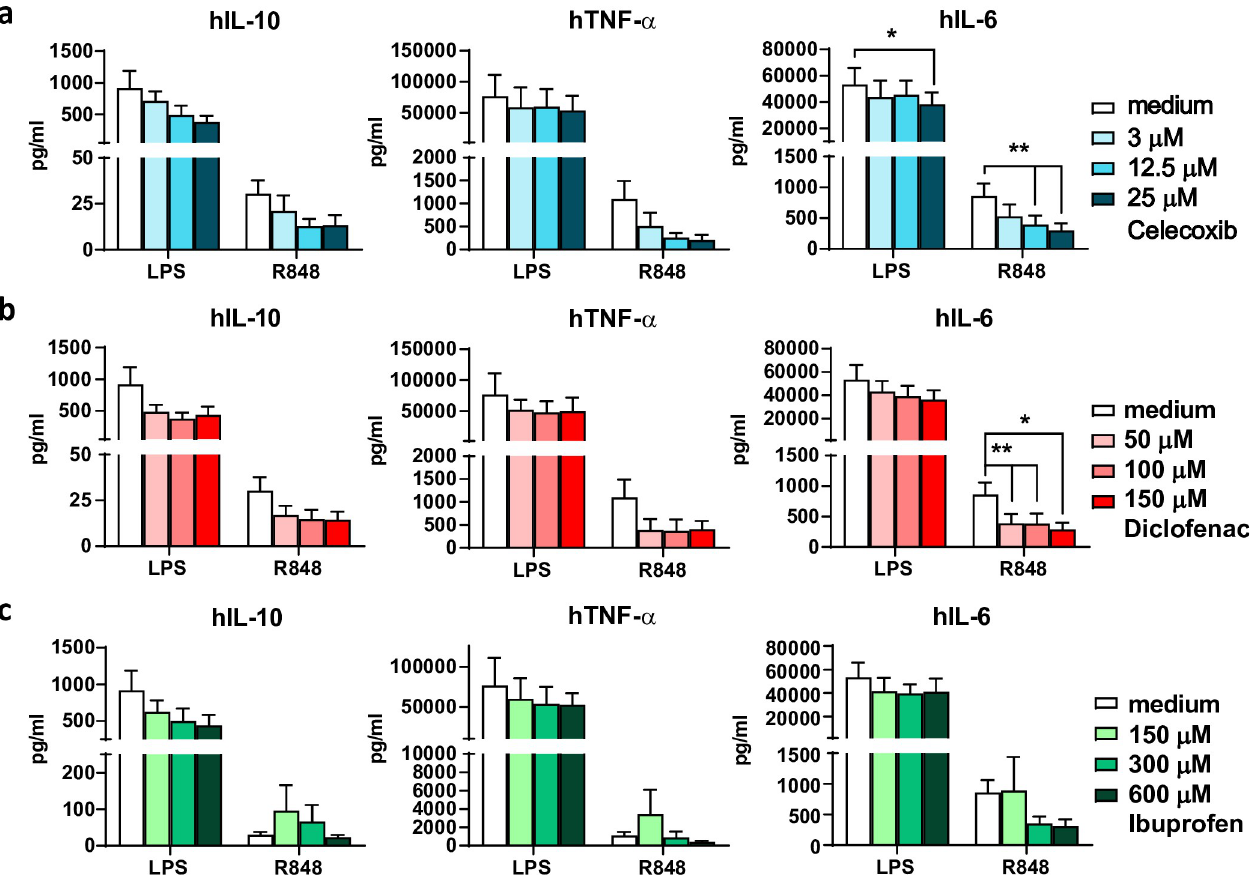
Fig 5. Decreased cytokine production by moDCs upon TLR stimulation when preincubated with NSAIDs. (a-c) moDCs were first pretreated with NSAIDs for 6 hr, followed by a 2.5 hr TLR stimulation with LPS or R848. After overnight rest in fresh medium, cytokines were measured using ELISA (n = 5–6). IL-10, TNF- α , and IL-6 production after TLR stimulation by (a) celecoxib, (b) diclofenac, and (c) ibuprofen preincubated moDCs. Results are shown as means with SEM. Statistical significance was calculated using Mixed-effects analysis with Dunnett’s multiple comparisons